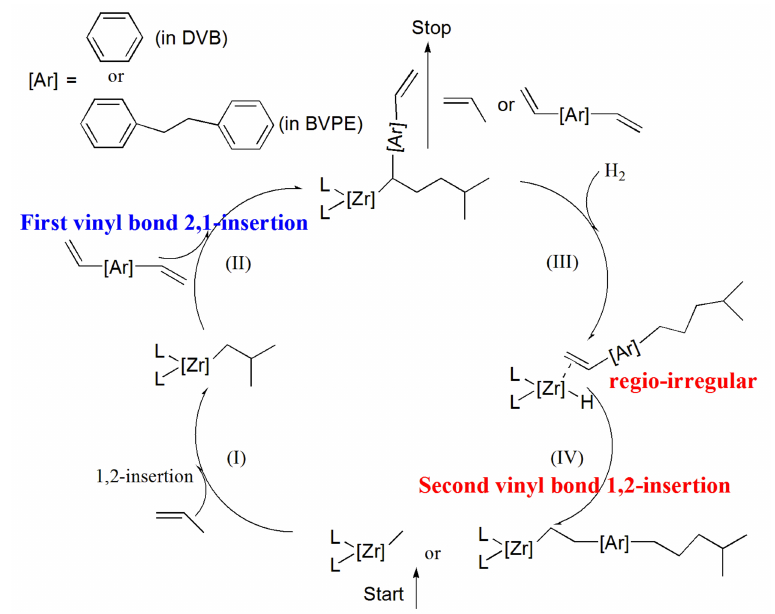
Scheme 1. Schematic illustration of chain transfer mechanism.